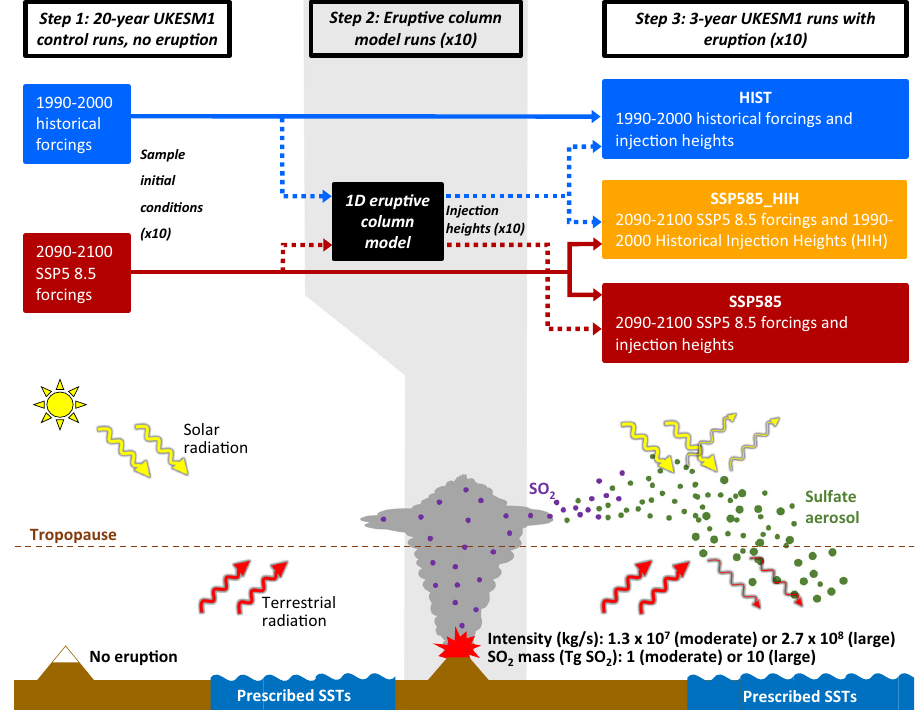
Fig. 1 Overview of our combined eruptive column-aerosol-climate modeling framework and experimental design to produce the three scenarios analysed in this study. Table 1 provides the SO 2 mass and eruption intensity used for each eruption scenario as well as key fi gures characterizing the HIST and SSP585 climate conditions. Further details on the models and design are provided in the Methods section. SST refers to sea-surface temperature and SSP5 8.5 is the high-end future climate scenario in projections of the UKESM1 Earth System